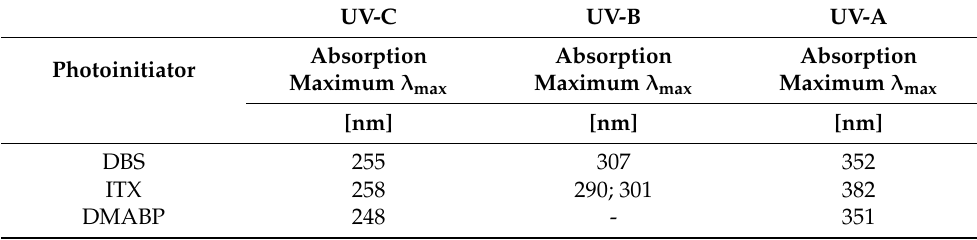
Table 3. Overview of important FTIR stretching and deformation vibrations in Durazane 1800 [38].